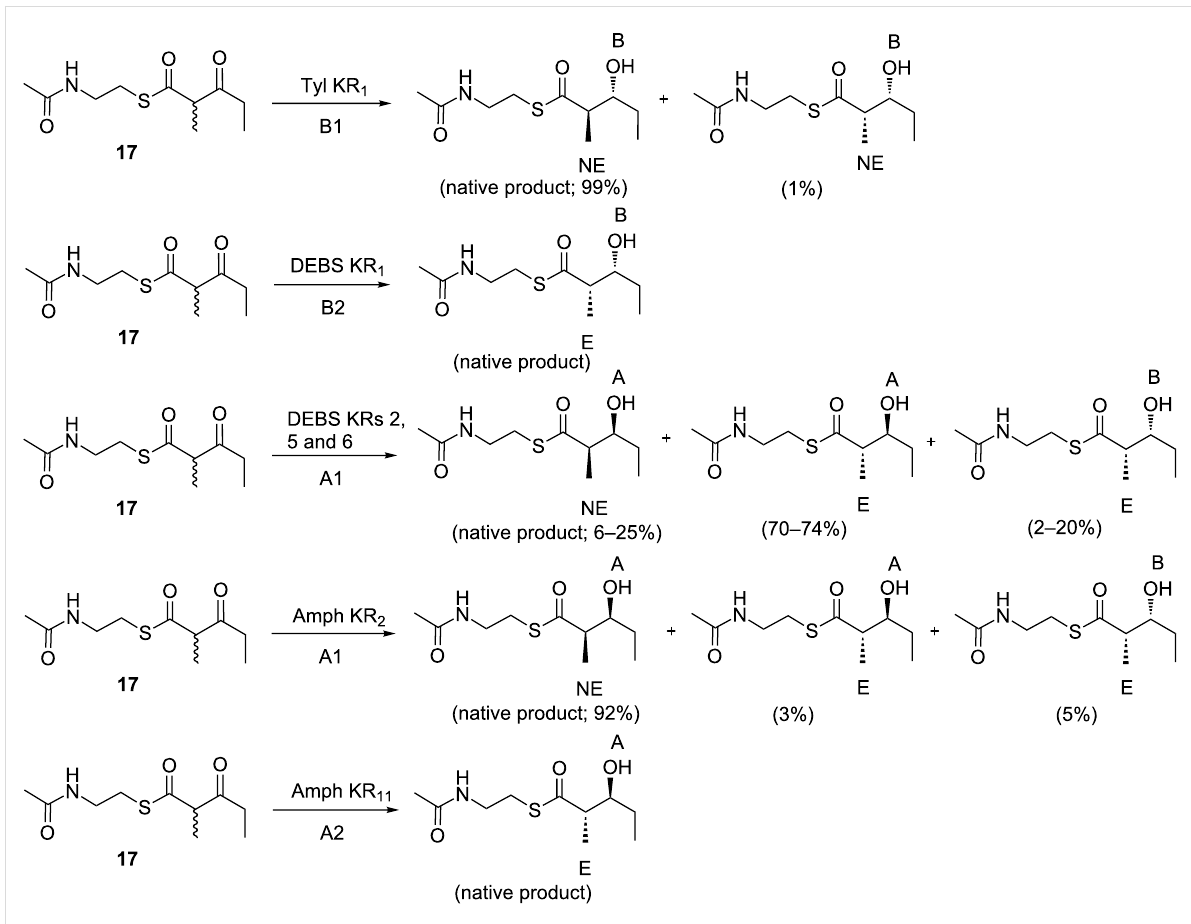
Figure 12: Assays in vitro to evaluate the stereospecificity of recombinant KR domains. A series of KR domains of all types (A1, A2, B1 and B2, as in- dicated) were investigated using a common substrate, racemic diketide derivatized as its N -acetylcysteamine (SNAC) thioester 17 . When the KR domains selected the appropriate substrate (C-2 non-epimerized (NE) for the type 1 domains and C-2 epimerized (E) for the type 2 domains), reduc- tion occurred almost exclusively in the correct direction. However, when substrate bearing the non-native C-2 stereochemistry was chosen, the oppo- site direction of reduction was also observed. The percentages of each product obtained are